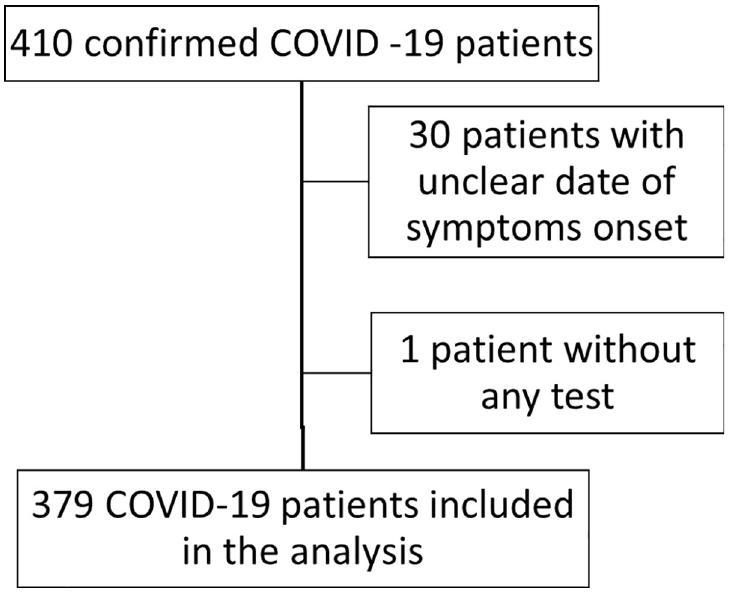
Fig 1. Selection of patients. Between January 29, 2020 and March 28, 2020, 410 patients tested positive to SARSCoV-2 RT-PCR were admitted in Spallanzani Hospital, of whom 379 were included in the analysis. For the 379